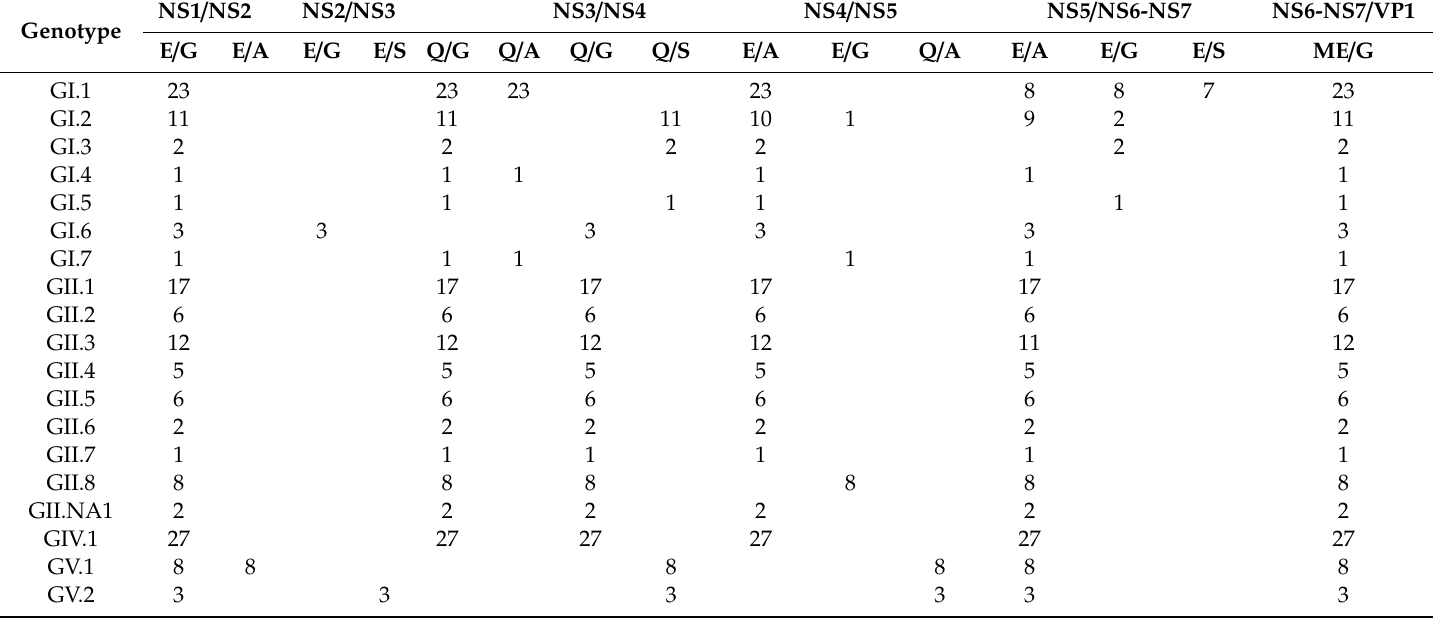
Table 2. Number of sequences by patterns of cleavage sites on the ORF1-encoding proteins. NS1 / NS2 NS2 / NS3 NS3 / NS4 NS4 / Genotype